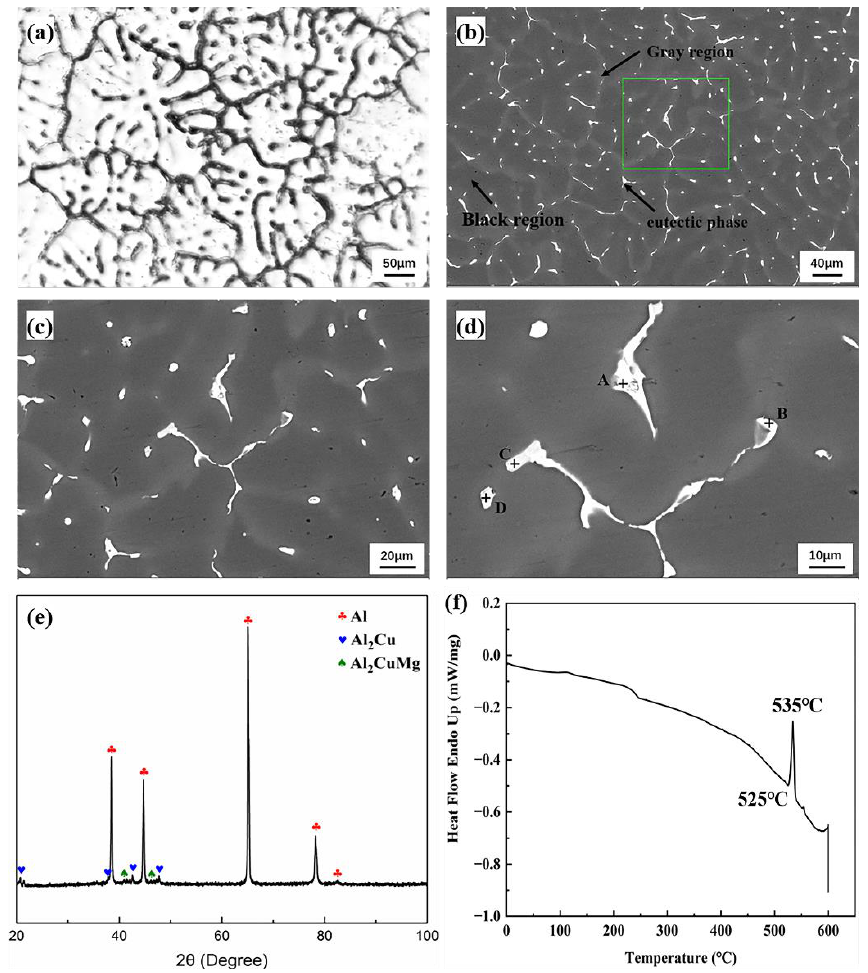
Figure 3. 2195 ingot microstructure: ( a ) ingot metallographic image; ( b ) in situ observation zone; ( c , d ) 500× and 1000× magnification of in situ observation zone; ( e ) ingot XRD; ( f ) ingot DSC.